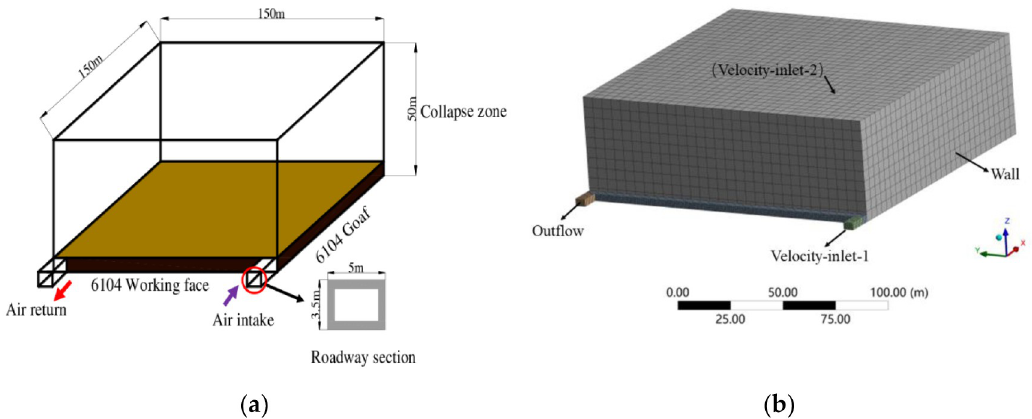
Fig 6. Numerical calculation model of goaf. (a) Physical model face; (b)